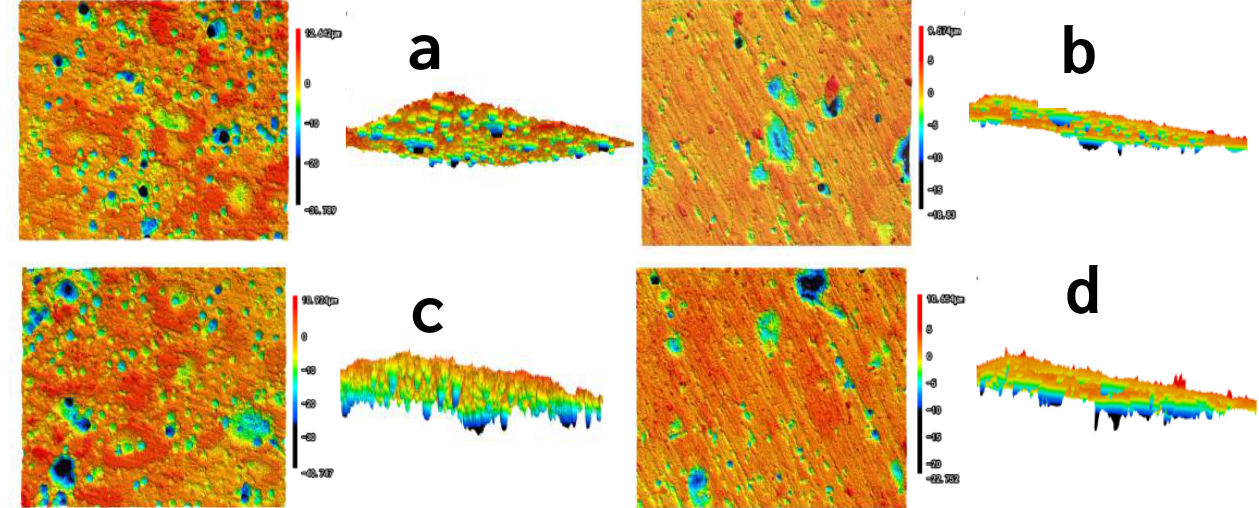
Figure 3. 3D corrosion morphology of different specimens after the immersion test. ( a , c ) represent the ductile iron that had not received surface mechanical treatment; ( b , d ) represent the ductile iron that had received surface mechanical treatment.